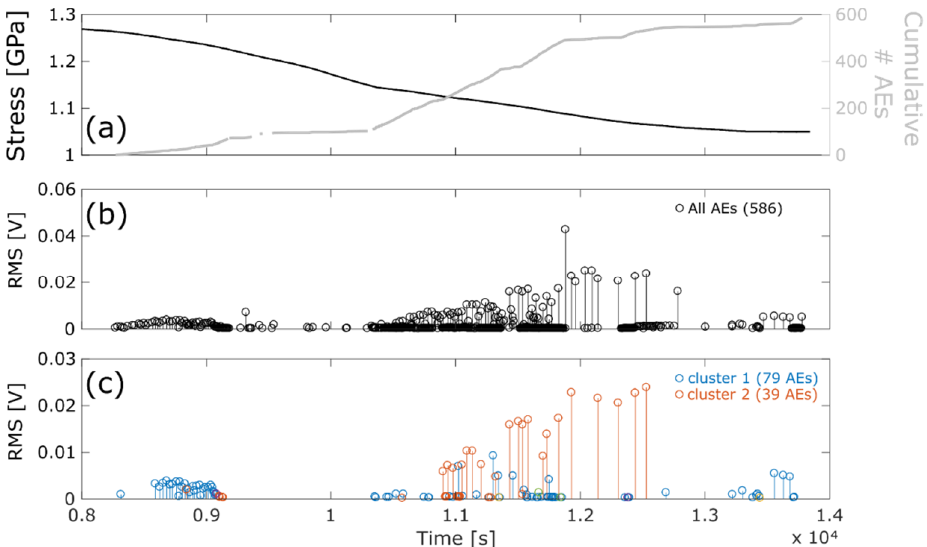
Figure 15. Results from AE clustering for experiment G15. ( a ) Shows the evolution of differential stress and cumulative number of AEs. ( b ) Shows the occurrence of AEs and their RMS values. ( c ) Shows the same plot where only clustered AEs are displayed and their assignment to a particular cluster is colour-coded. Note that only the two largest clusters are given in the inset legend.